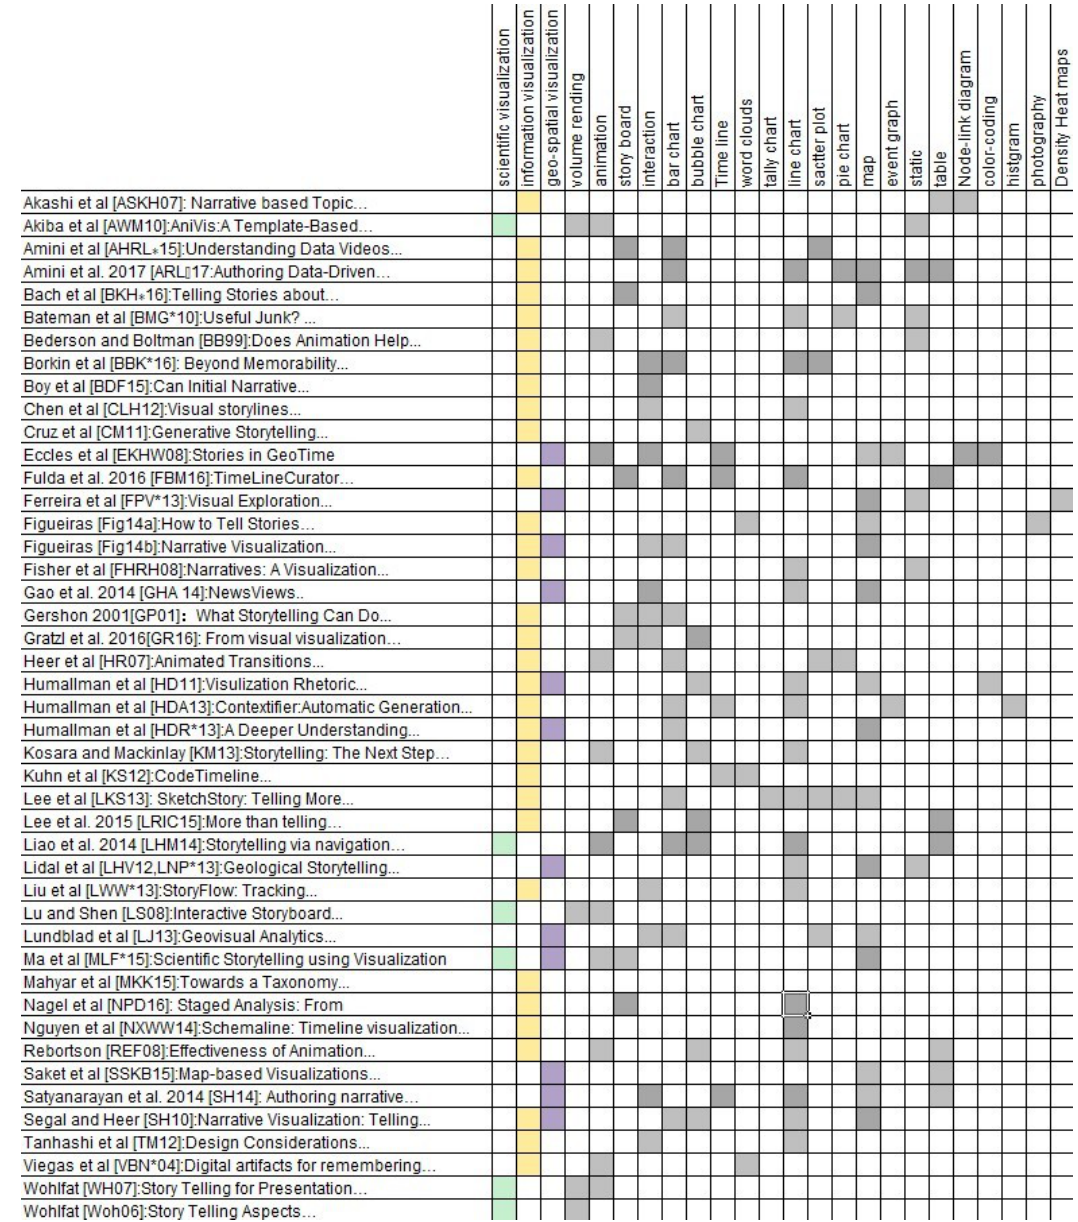
Figure 2. A table summarizing the visualization techniques used in each storytelling paper. The papers are sorted alphabetically by the first author’s